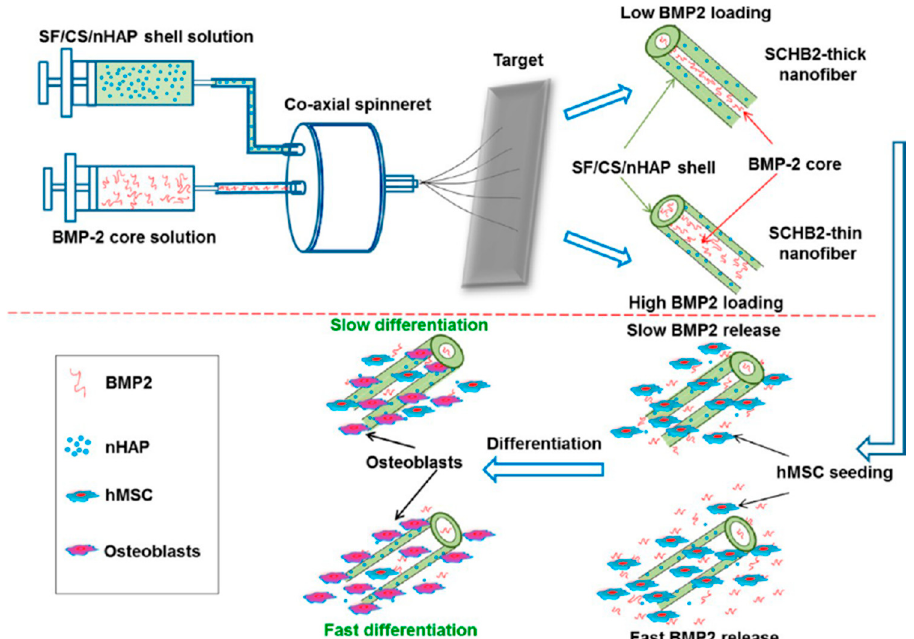
Figure 3. Schematic Representation of the Preparation of SCHB2-Thick and SCHB2-Thin Nanofibrous Membranes through Coaxial Electrospinning and Their Influence on human marrow mesenchymal stem cells. Reprinted with permission from American Chemical Society 2015 [140].